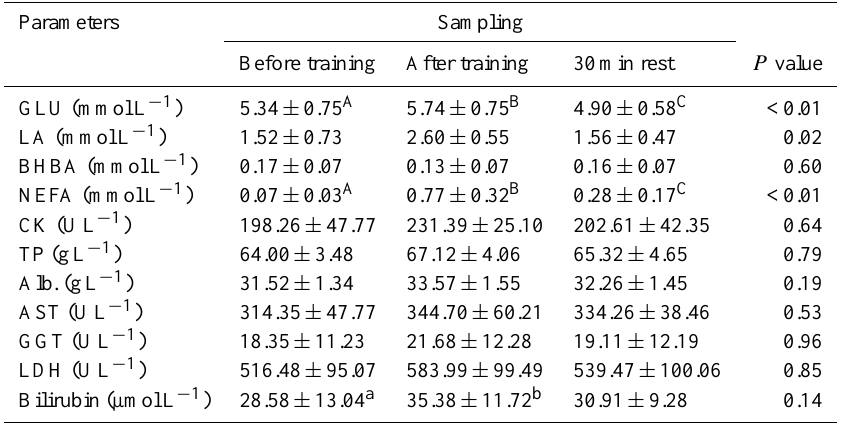
Table 3. Concentration of biochemical parameters and enzyme activity before training, after training and after a 30min rest period (mean ± standard